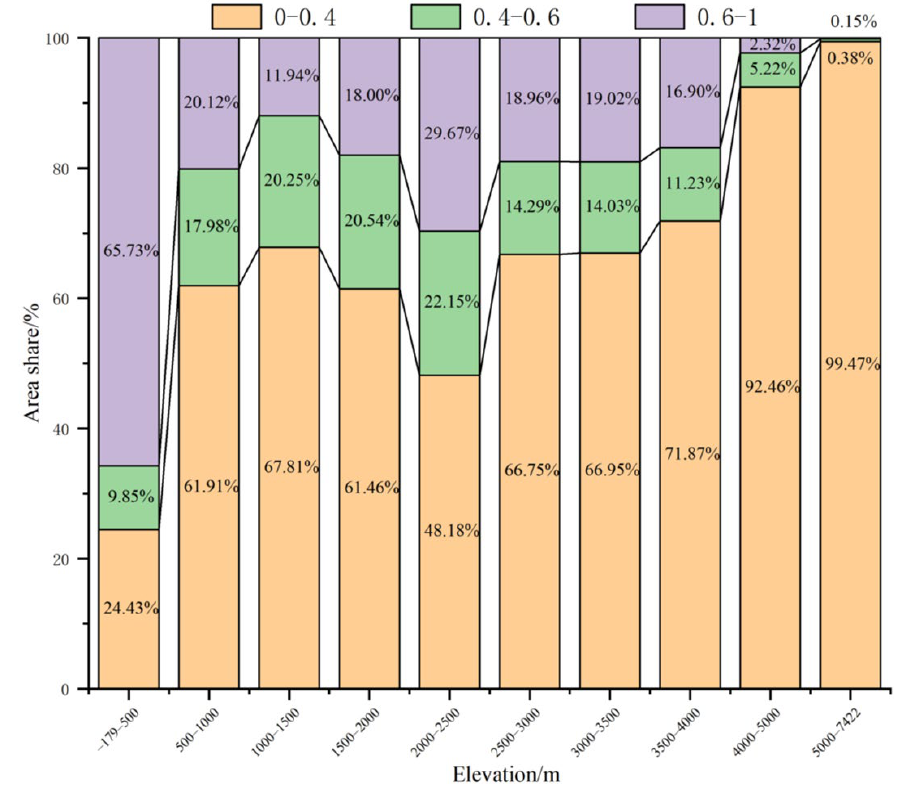
Figure 10. Percentage of FVC at different elevations in the Three North Protection Forest Project area.